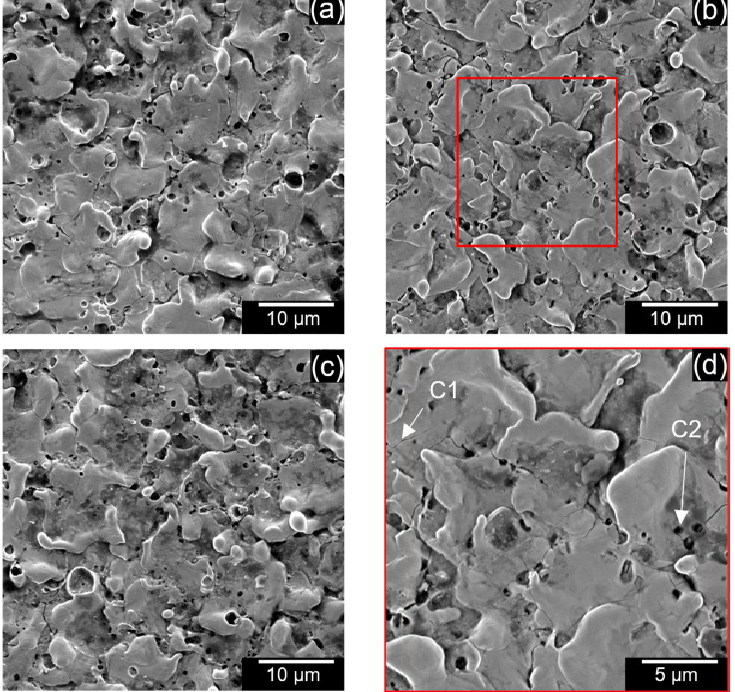
Figure 12. SEM of the machined surface using oil-only at ( a ) 90 V, ( b ) 100 V, ( c ) 110 V, and ( d ) enlarged region of 100